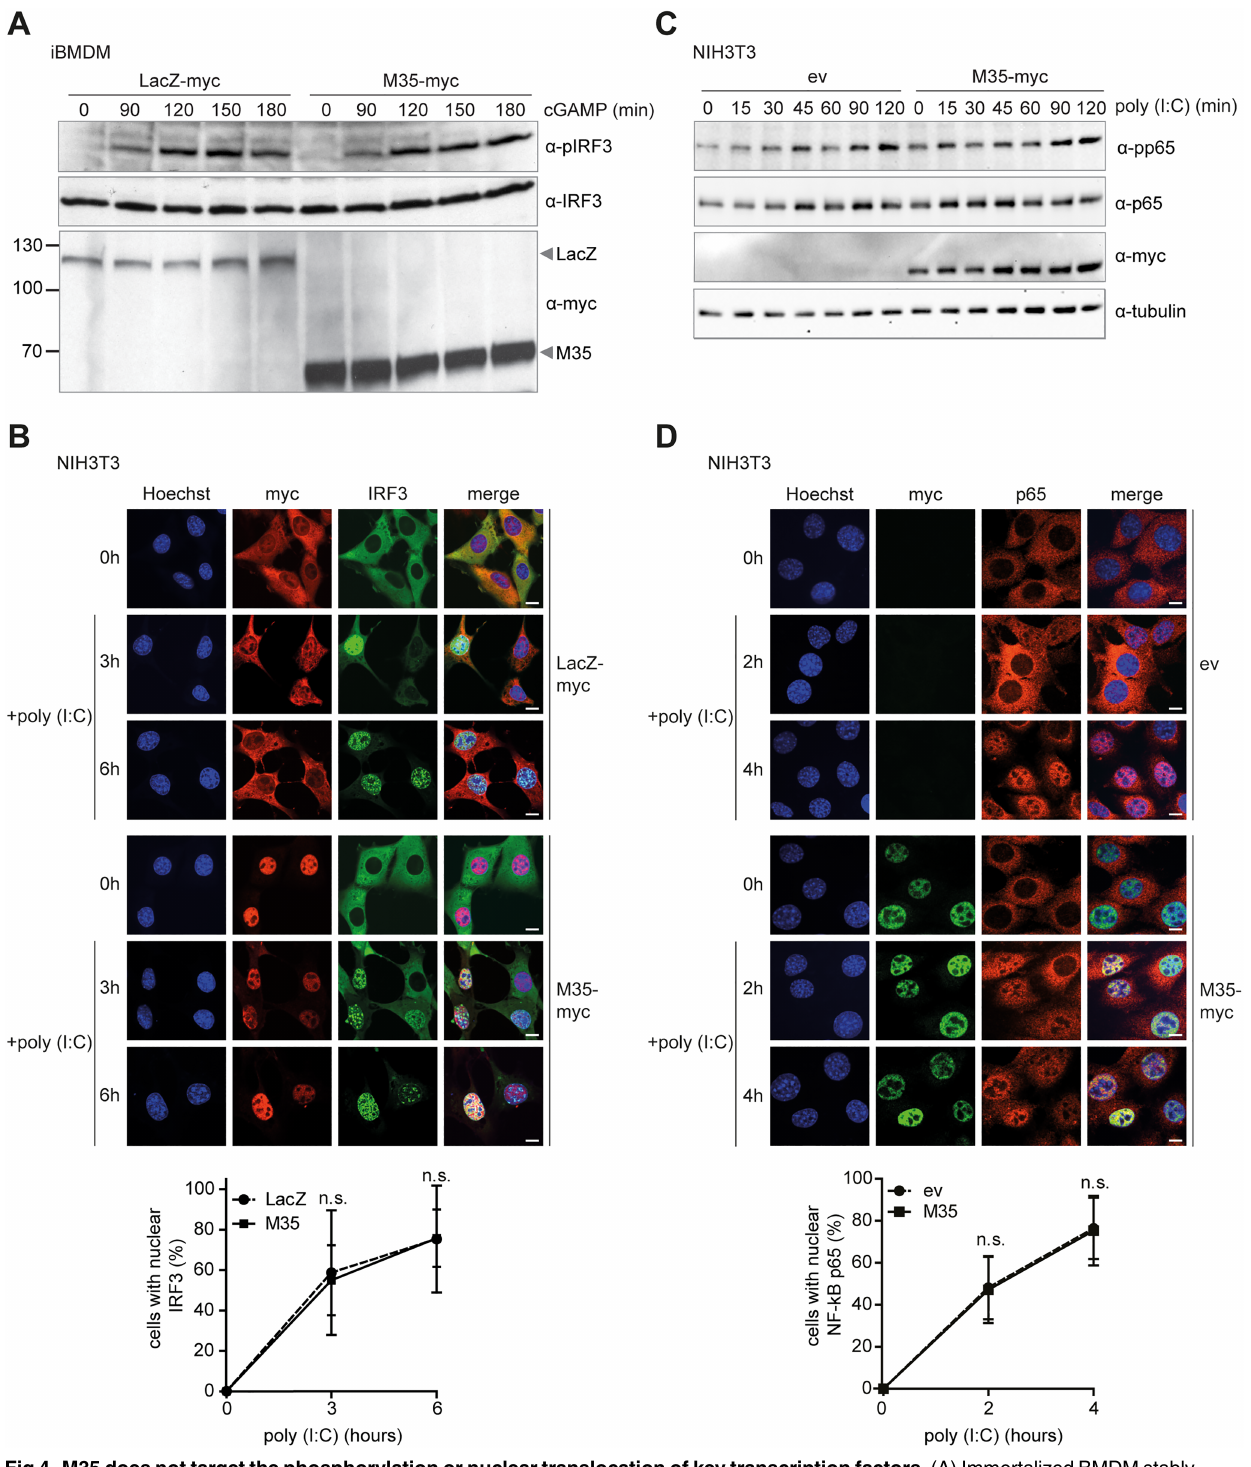
Fig 4. M35 does not target the phosphorylation or nuclear translocation of key transcription factors. (A) Immortalized BMDM stably expressingLacZ-myc or M35-myc were stimulatedby additionof 3 μ g/ml cGAMP and cells lysed at indicatedtime points. Lysates were separated by SDS-PAGE and endogenousIRF3 and phospho-IRF3 were detected with specific antibodies. Expression of myc-taggedLacZ and M35 was verifiedwith a myc-specific antibody. Immunoblot shown is representative of three independent experiments. (B) NIH3T3 fibroblasts stably expressingmyc-taggedLacZ or M35 and eGFP-IRF3 were stimulatedby transfectionof 10 μ g/ml poly(I:C) with Lipofectamine 2000. At